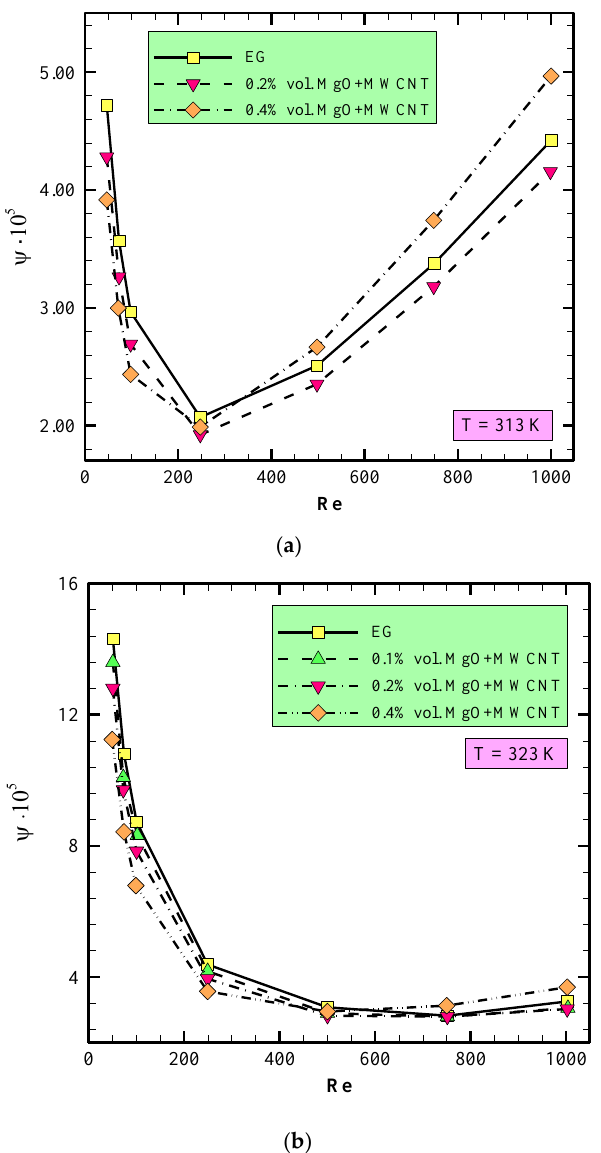
Figure 18. Effects of HNF with different VF on dimensionless entropy generation for different Re and inlet temperatures of ( a ) T = 313 K and ( b ) T = 323 K.